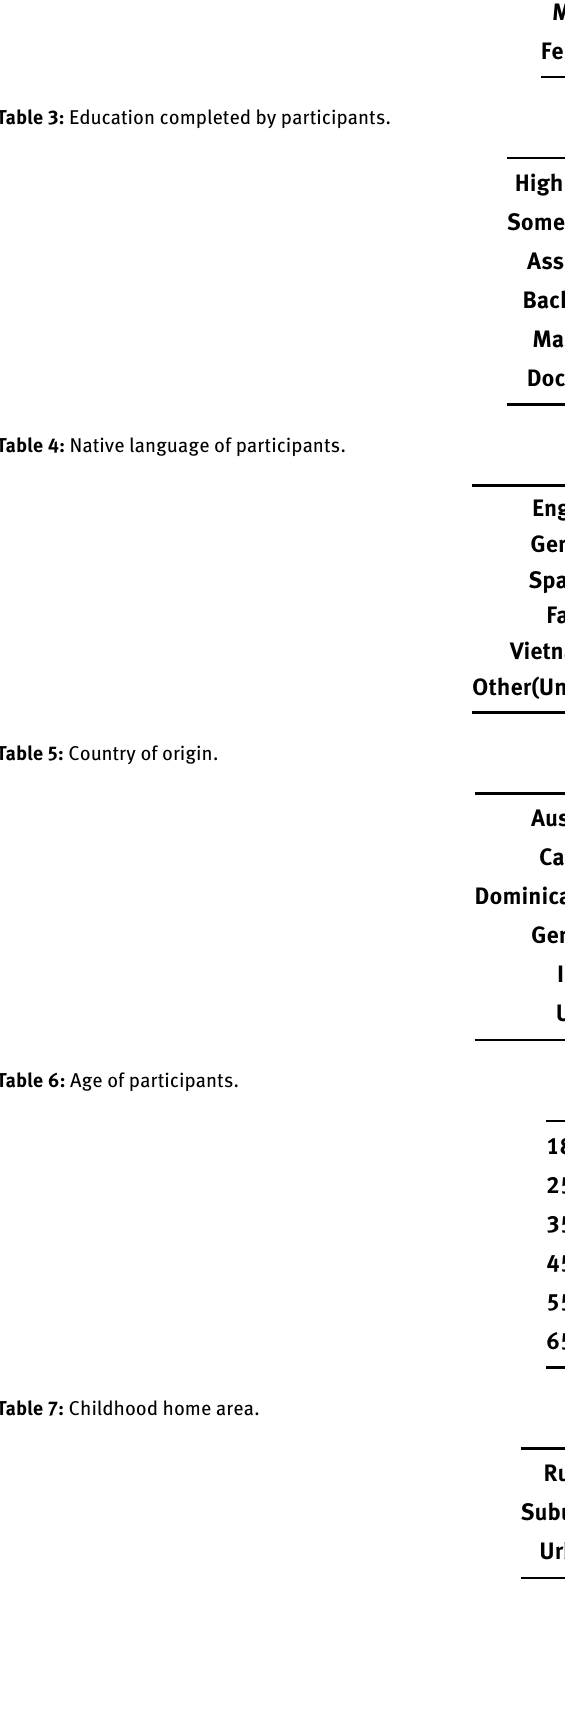
Table 3: Education completed by participants.